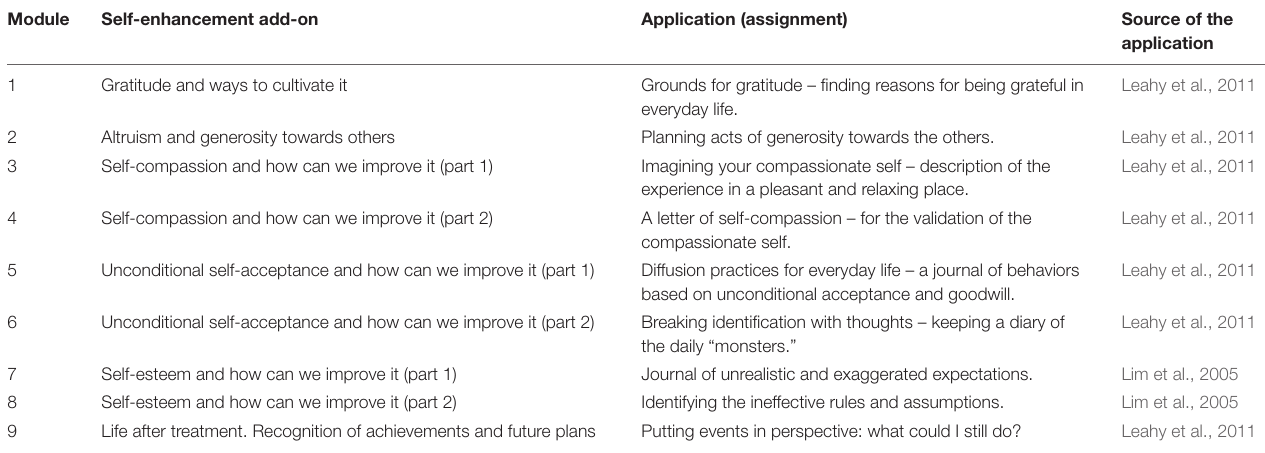
TABLE 1 | Overview of the newly added self-enhancement